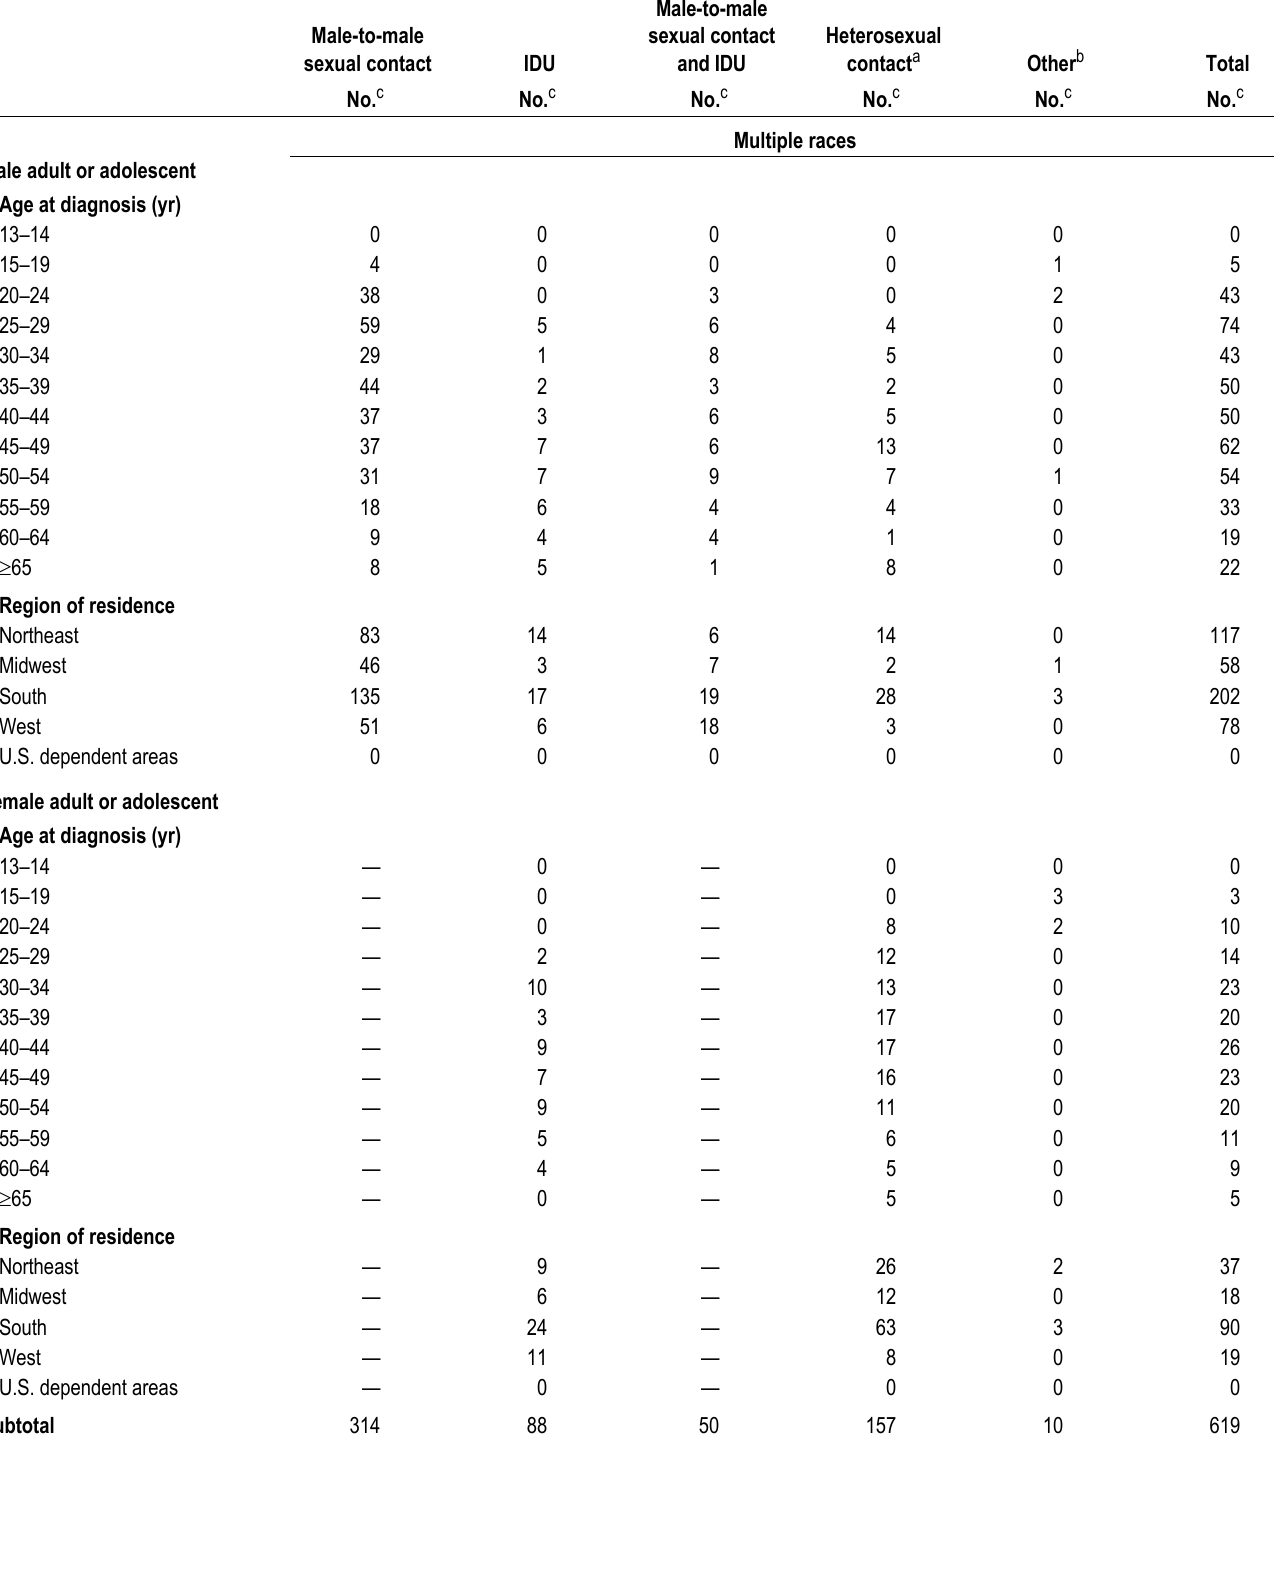
Table 6b. Stage 3 (AIDS), by transmission category, race/ethnicity, and selected characteristics, 2015—United States and 6 dependent areas